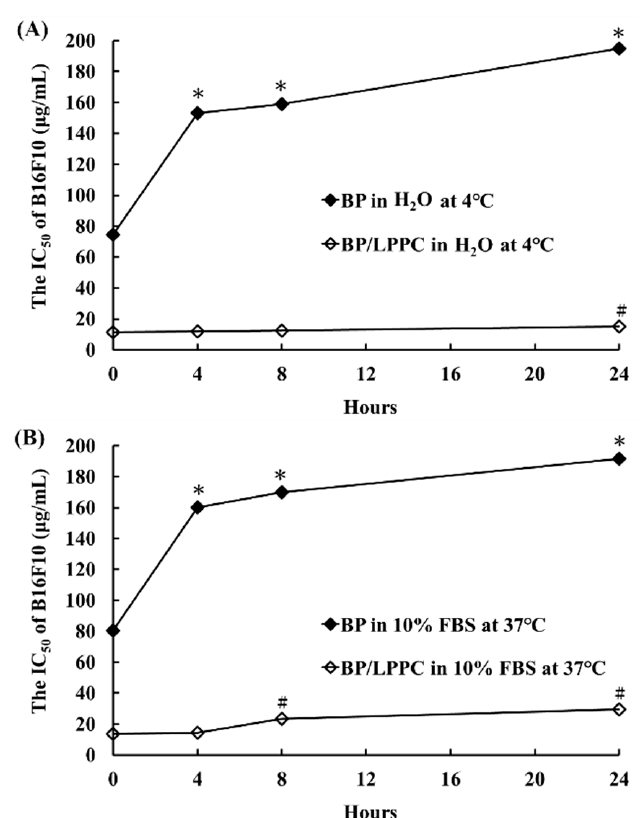
Figure 5. LPPC encapsulation stabilized and maintained BP activity for cytotoxicity of melanoma cells. The LPPC non-capsulated BP (BP group) and capsulated BP (BP/LPPC group) were stored in ( A ) ultra pure and sterile water (H 2 O) at 4 ◦ C or ( B ) 10% fetal bovine serum (FBS) in phosphate-buffered saline (PBS) at 37 ◦ C environment for 0, 4, 8, and 24 h and calculated cytotoxicity (IC 50 ) of BP using MTT assay. * p < 0.05 versus control dose (0 µ g/mL) in BP group. # p < 0.05 versus control dose (0 µ g/mL) in BP/LPPC group.